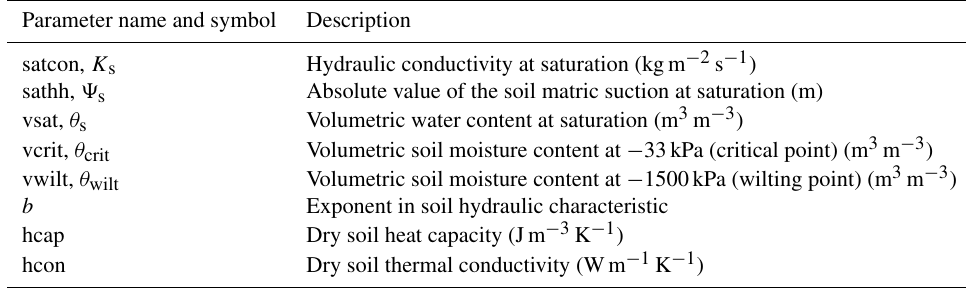
Table 1. Soil physics parameters.